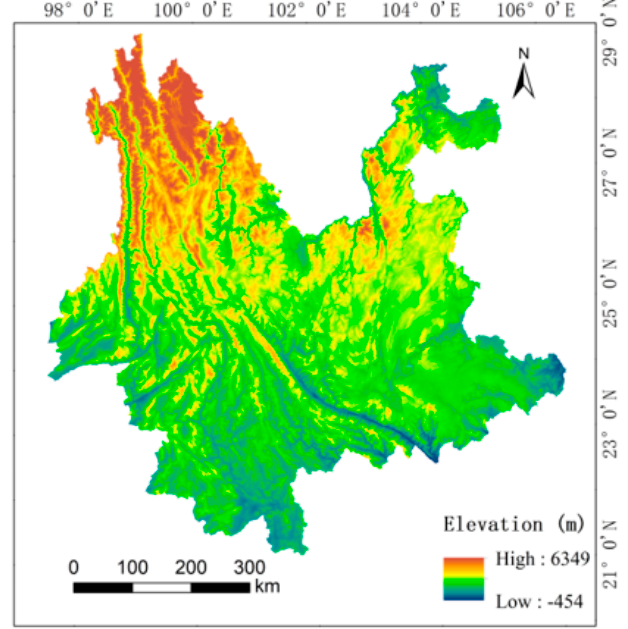
Figure 1. Overview of the study area.